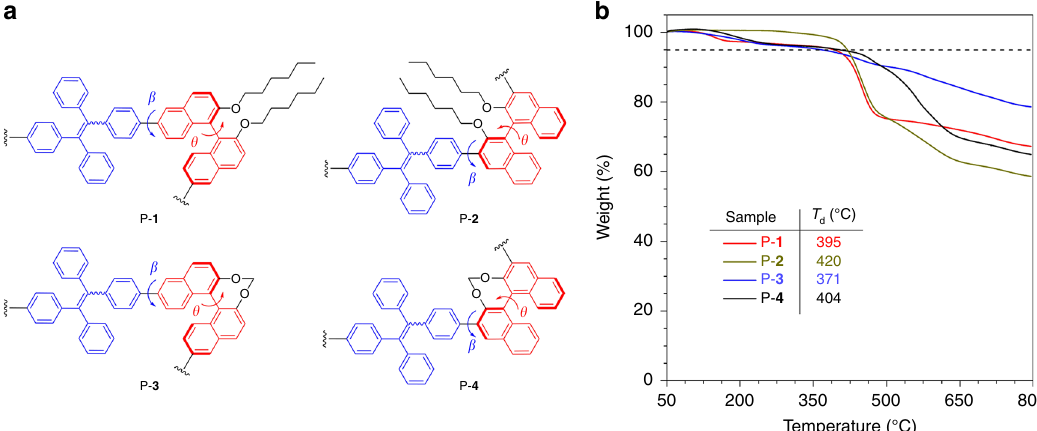
Fig. 2 Structural and thermodynamic information. a Chemical structures of polymers P- 1 , P- 2 , P- 3 , and P- 4 , and their b thermogravimetric analysis (TGA) thermograms recorded under N 2 at a heating rate of 10